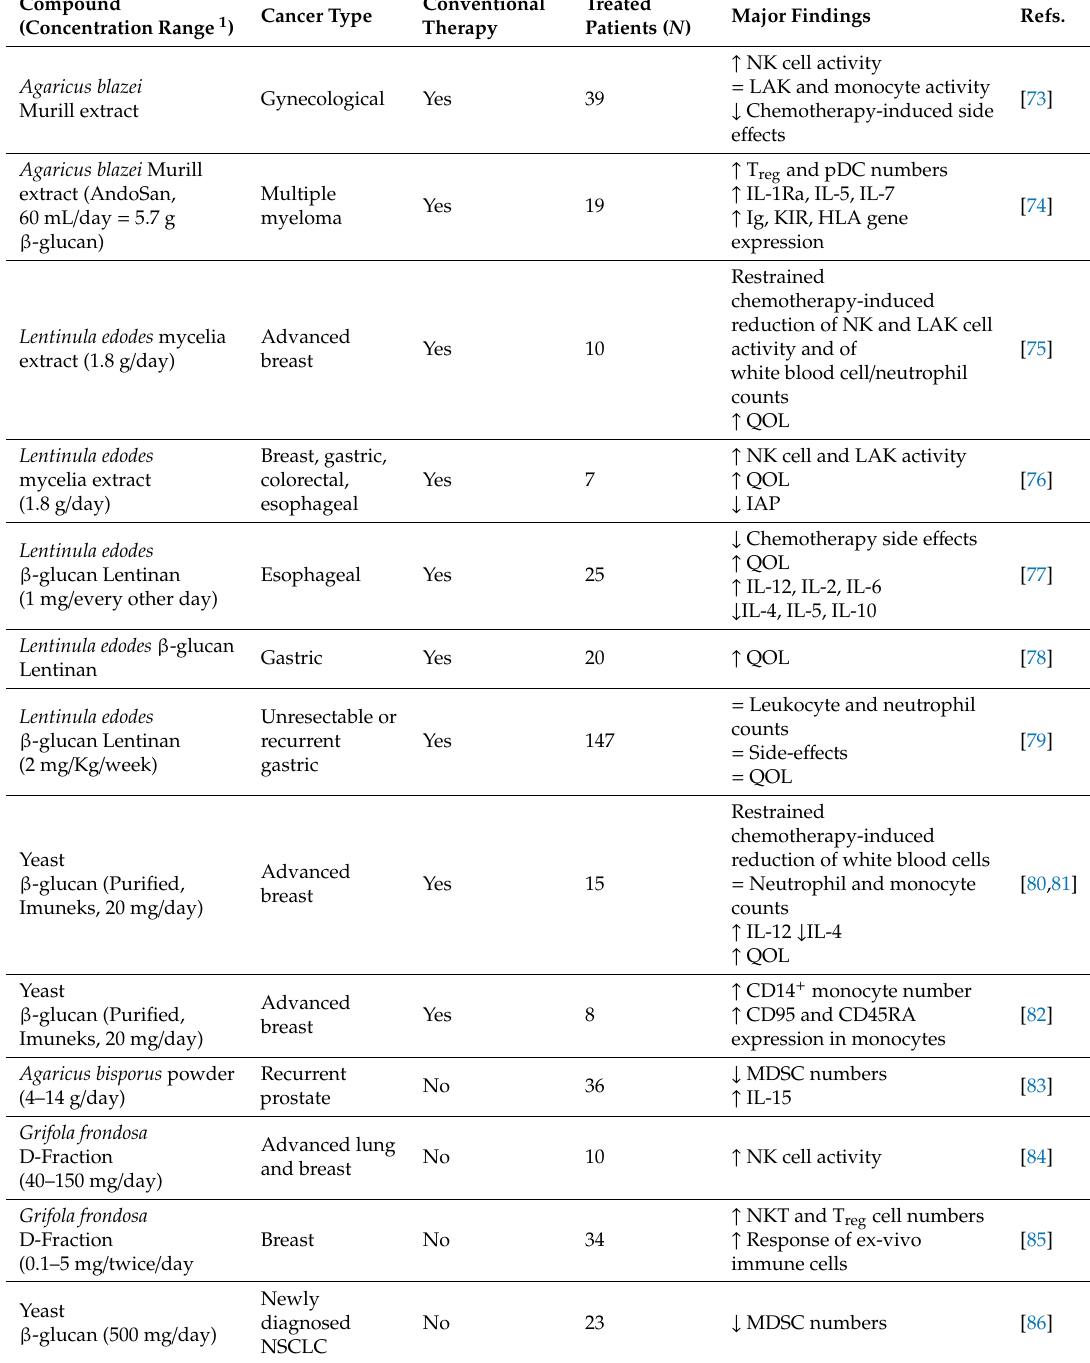
Table 3. Main clinical studies evaluating the immunomodulatory e ff ects of β -glucans in cancer patients. Compound (Concentration Range 1